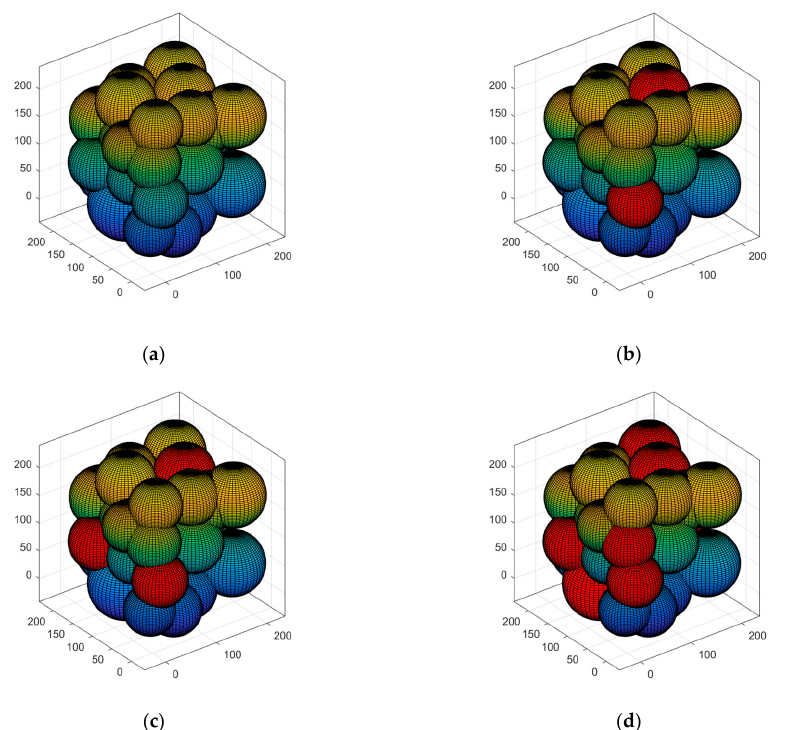
Figure 12. Different rounds of coverage in medium-sized networks: ( a ) Network runs 50 rounds; ( b ) Network runs 5000 rounds; ( c ) Network runs 10,000 rounds; ( d ) Network runs 15,000 rounds.